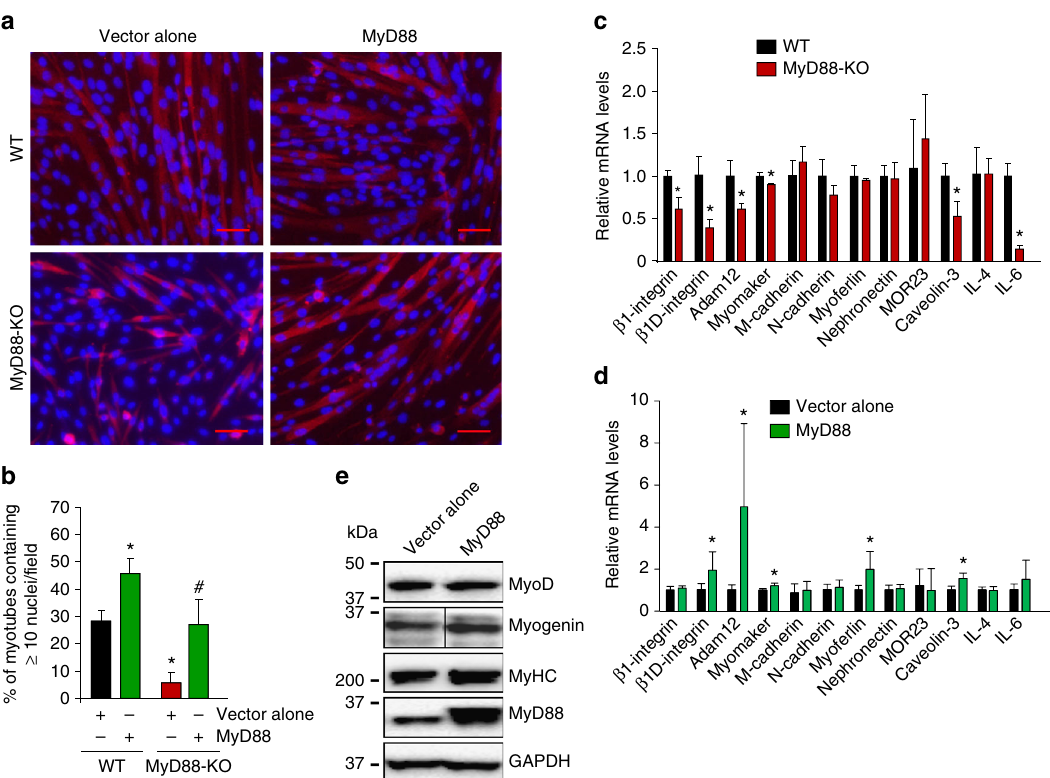
Fig. 3 MyD88 promotes myoblast fusion through augmenting the expression of profusion molecules. a Primary myoblasts prepared from hind limb muscle of WT and MyD88-KO mice were transfected with empty vector or vector containing MyD88 cDNA. The cells were incubated in DM for 48 h followed by staining with anti-MyHC and DAPI. Scale bar: 50 µ m. b Quanti fi cation of the percentage of myotubes containing ≥ 10 nuclei in WT and MyD88-KO cultures. N = 5 in each group. Error bars represent s.d. * p < 0.01 from WT cultures transfected with vector alone by unpaired t -test. # p < 0.01 from MyD88 cultures transfected with vector alone by unpaired t -test. c Primary myoblasts prepared from hind limb muscle of WT and MyD88-KO mice were incubated in DM for 48 h after which samples were processed for QRT – PCR analysis to measure relative mRNA levels of indicated profusion molecules. N = 3 in each group. * p < 0.05 from WT cultures by unpaired t -test. Primary myoblasts were prepared from hind limb muscle of WT mice and transfected with empty vector or vector containing MyD88 cDNA. Cells were then incubated in DM for 48 h and d processed for gene expression of indicated profusion molecules using QRT – PCR assay. N = 5 – 6, * p < 0.05 from cultures transfected with vector alone by unpaired t -test. e Protein lysates were prepared and blotted for MyoD, myogenin, MyHC, MyD88 and unrelated protein GAPDH. Vertical black line indicates that intervening lanes were spliced